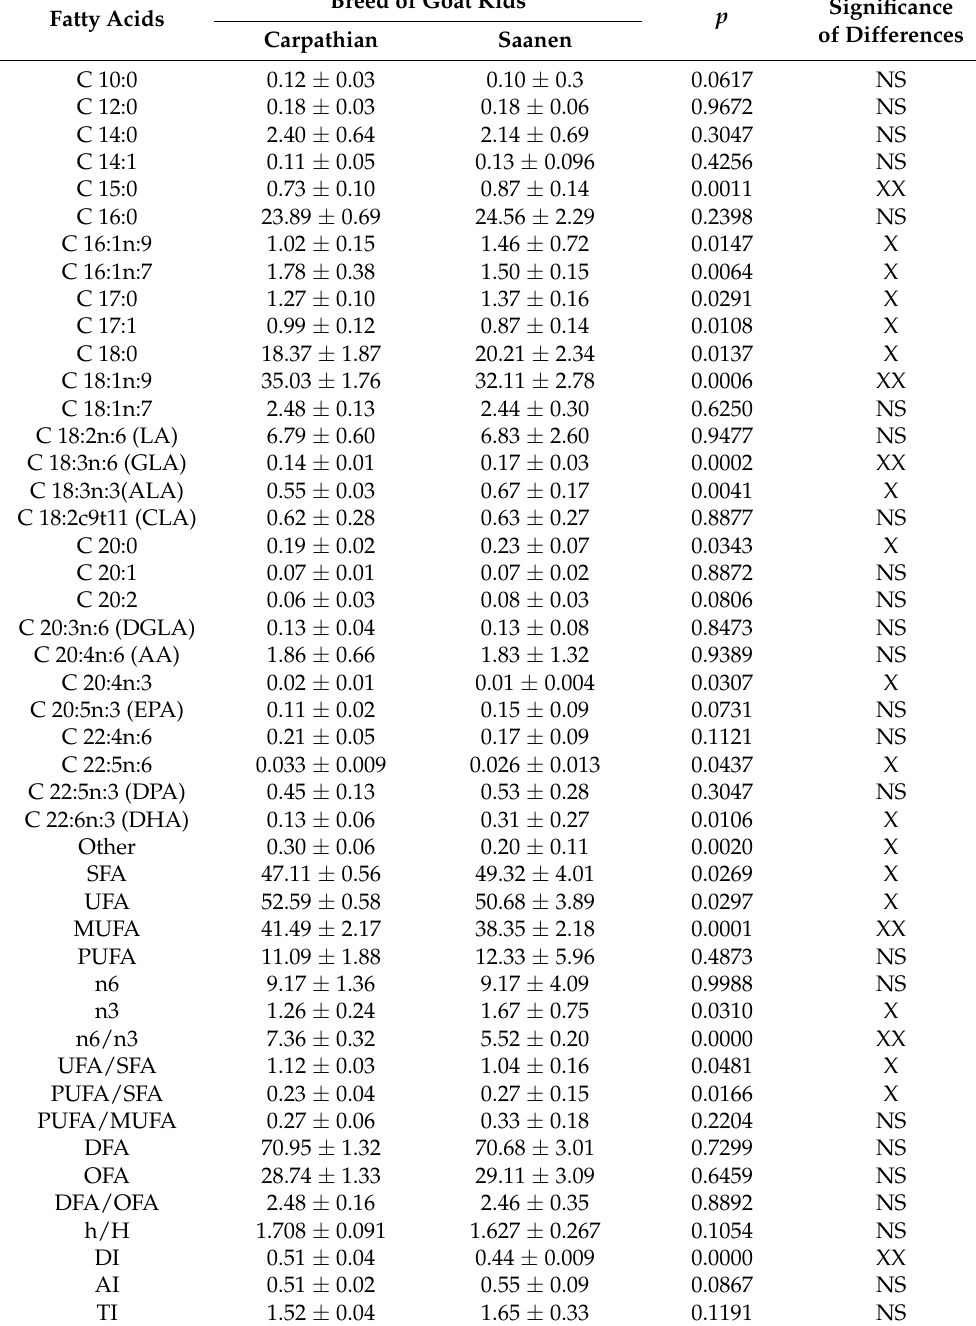
Table 4. Fatty acid composition in intramuscular fat from male kid goats